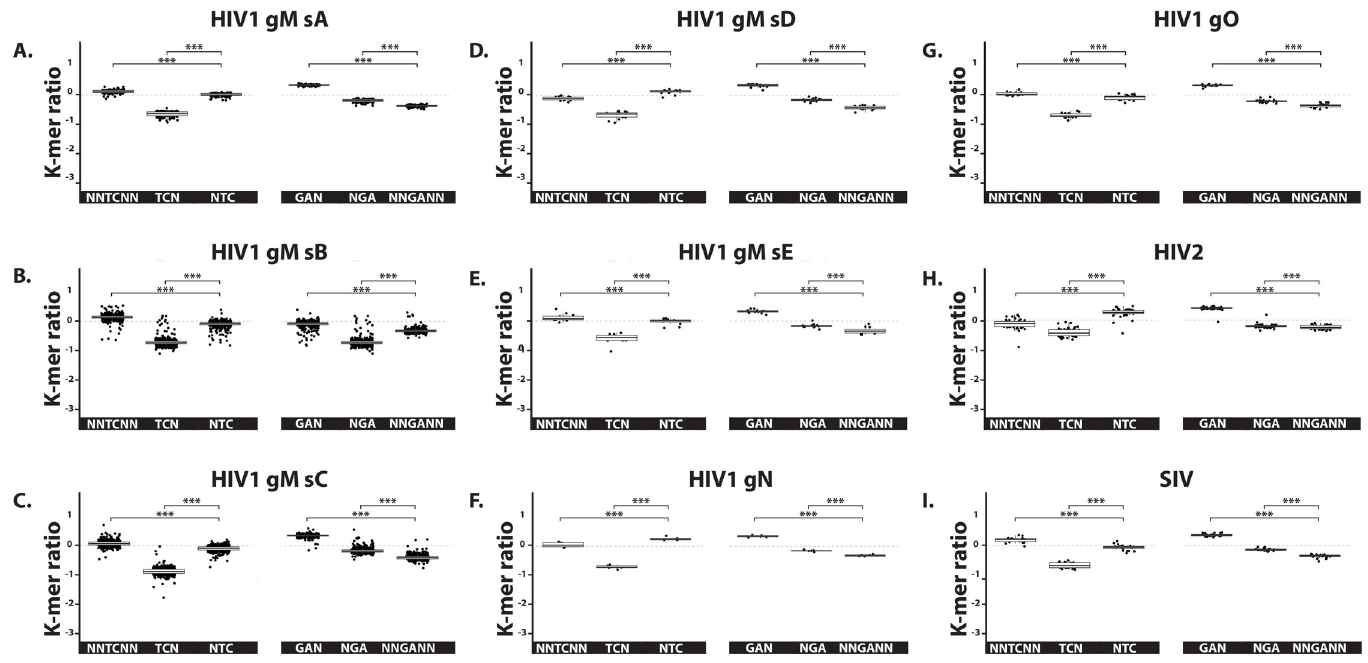
Fig 11. A3 footprint on the negative strand of HIV-1, HIV-2 and SIV. The observed/expected ratios of TC dinucleotide at various codon positions and on both strand (i.e. NNTCNN, TCN, NTC, GAN, NGA and NNGANN) were calculated for the genomes of HIV-1 (distributed into their respective groups and subtypes, panels A to G), HIV-2 (panel H) and SIV (panel I). Each point stands for a unique full-length viral genome. Median and quartile are depicted by a boxplot. P-values were calculated by Student’s unpaired, two-tailed t-test (NS for not significant, � p < 0.05, �� p < 0.01, ��� p <